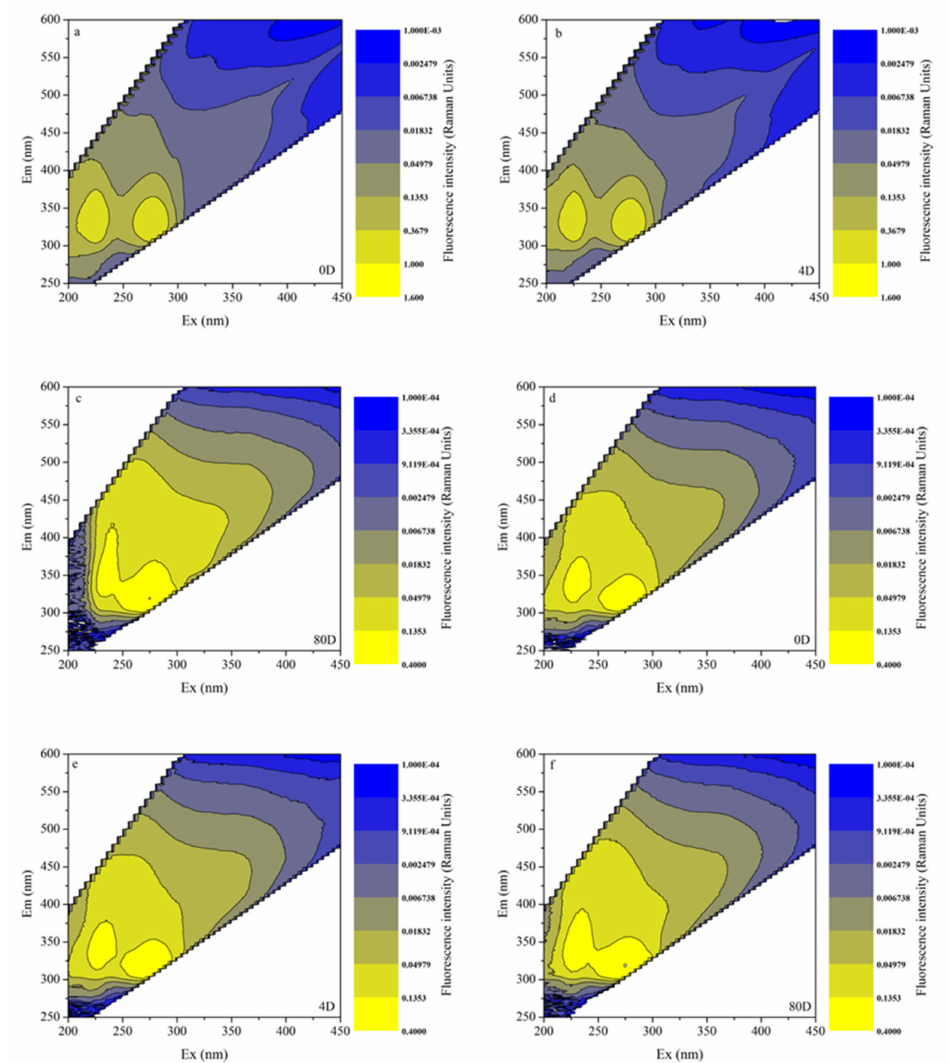
Figure 4. Chromophoric dissolved organic matter (CDOM) fluorescence properties variability by excitation-emission matrix spectra (EEMs) during the degradation processes of the bulk algal-derived dissolved organic matter (DOM) group on ( a ) day 0; ( b ) day 4; and ( c ) day 80, and in the natural lake water group (as control) on ( d ) day 0; ( e ) day 4; and ( f ) day